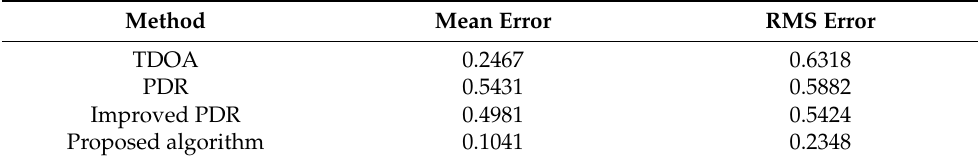
Table 4. Comparison of localization accuracy with different algorithms (m) (Third